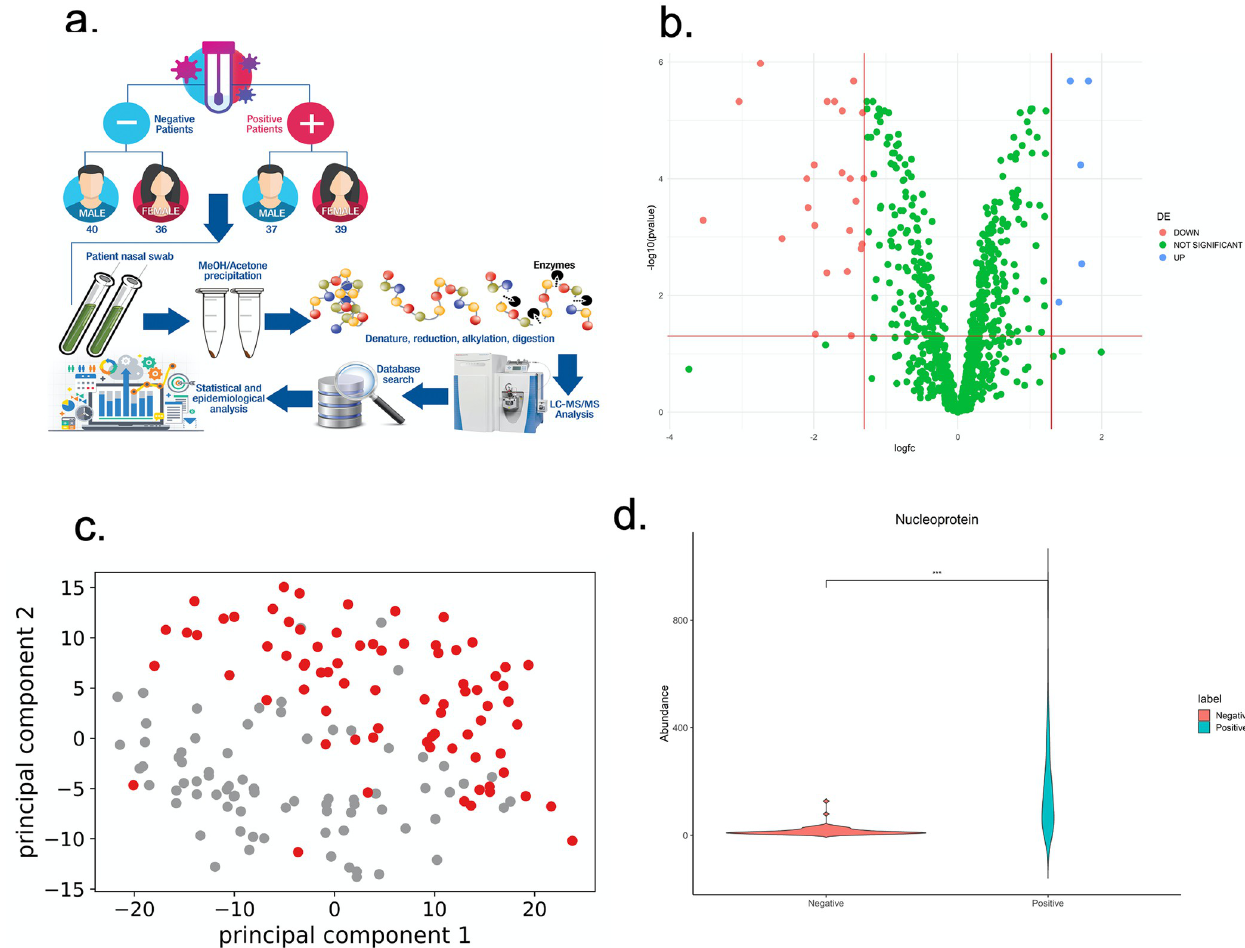
Fig 1. a. Overview of the workflow for data collection and proteomics analysis process. b. Volcano plot of mass spectrometry identified proteins in human nasopharyngeal environment. Proteins that were significantly up-regulated (log 2 FC > 1.3, p < 0.05) in SARS-CoV-2 positive patients were highlighted in blue, and proteins that were significantly down-regulated log 2 FC < − 1.3, p < 0.05) were highlighted in red. c. Principal Component Analysis indicated SARS-CoV-2 positive patients (red) clustered differently from negative patients (grey). d. Nucleoprotein was identified in SARS-CoV-2 samples and low confidence peptide background resulted from algorithm was identified in negative